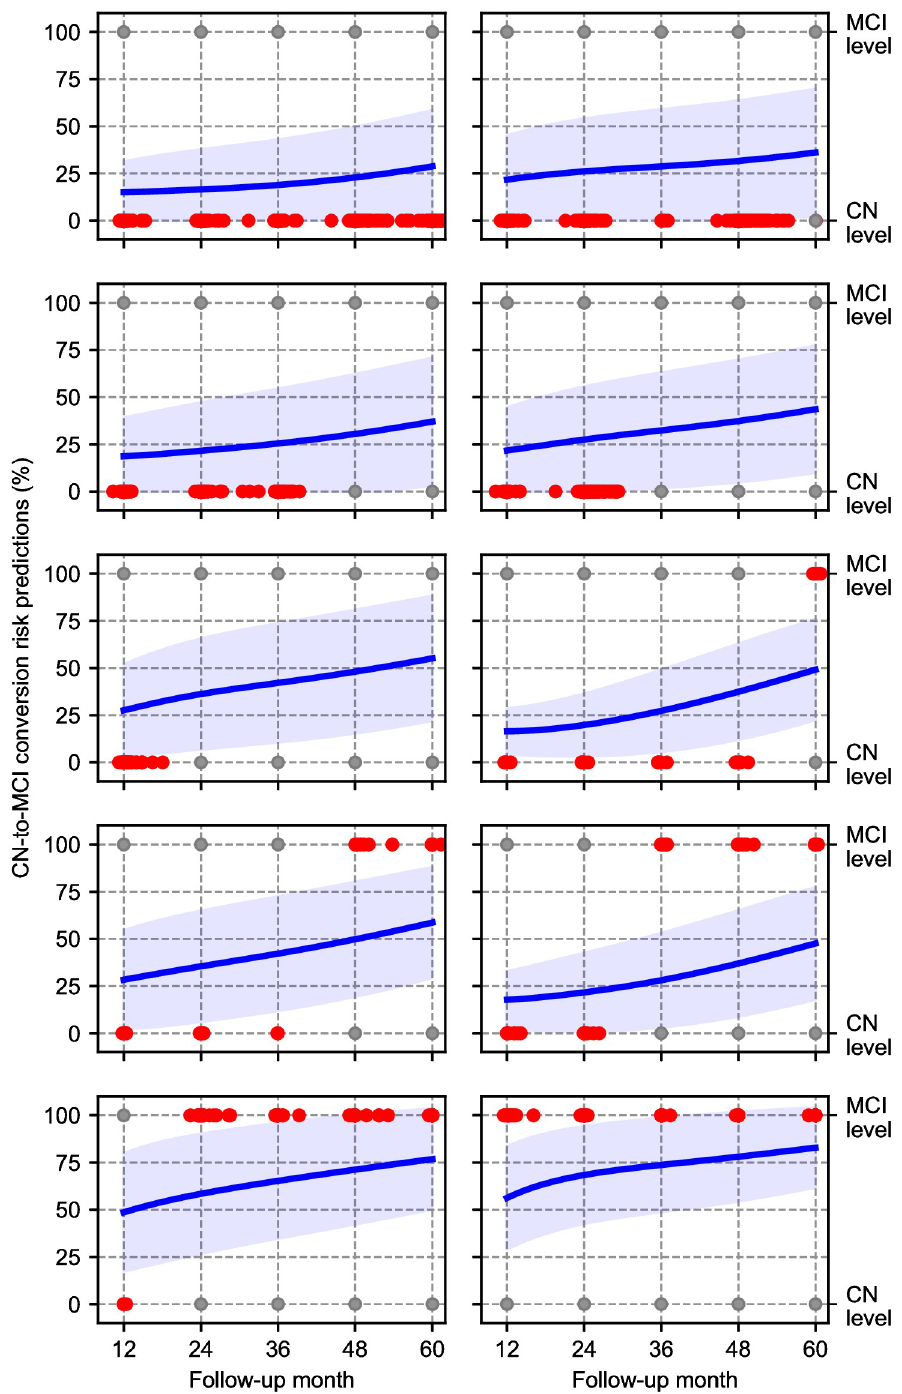
Fig 5. Conversion risk predictions of NMM for CN baseline participants with different ground truth disease trajectories. Blue line is the average MCI conversion risk with 68% confidence. Red dots represent the observed diagnosis time ( x -coordinate) and the observed diagnosis ( y -coordinate) of the participants with the corresponding trajectory. Grey dots are for reference.